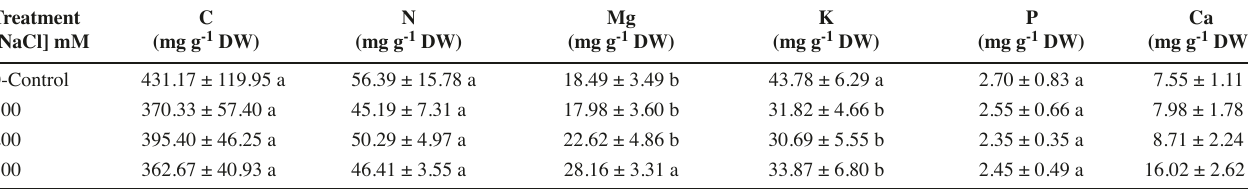
Tab. 4: Foliar concentrations of macronutrients in iceplant subjected to different salt conditions. Treatment